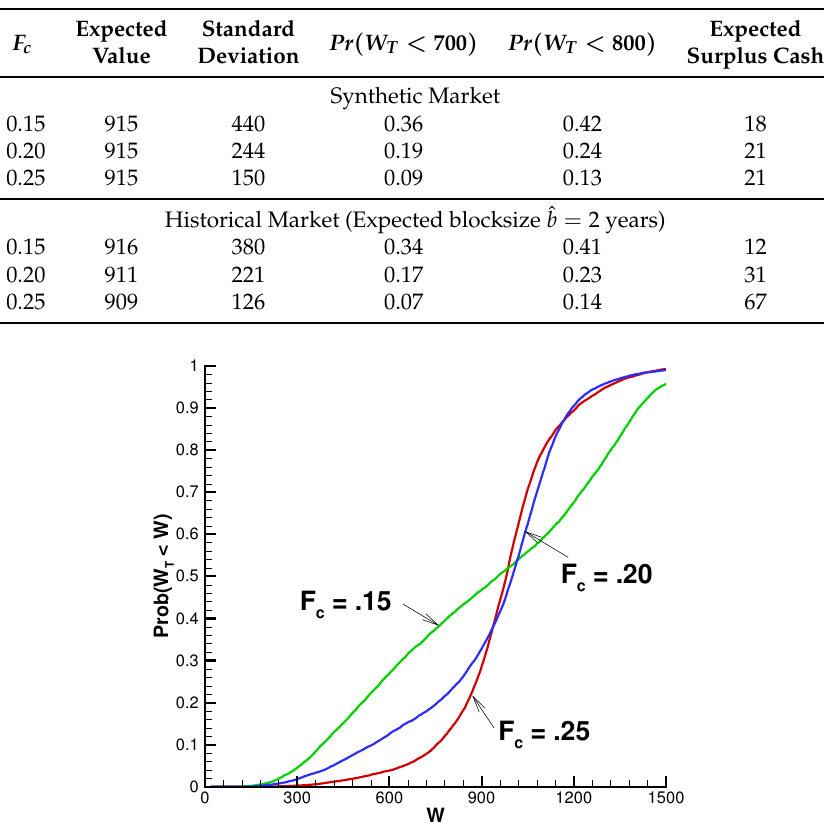
Figure 4. Cumulative distributions of real terminal wealth for various contribution fractions F c for the QS optimal strategy. Wealth units: thousands of dollars. Input data provided in Tables 1 and 2, except as noted. Historical market results based on 10,000 bootstrap resampled paths using data from 1926:1 to 2015:12 with expected blocksize ˆ b = 2 years; surplus cash